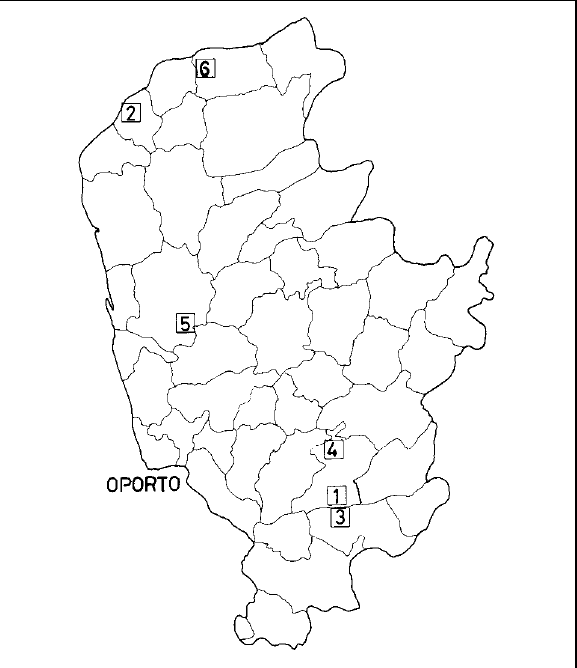
Fig. 1. Map of Portugal showing the region of Vinho Verde .